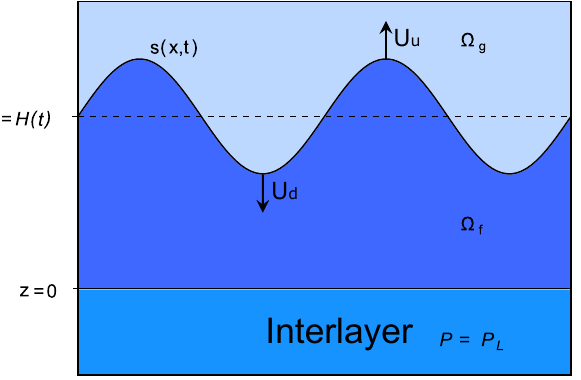
Figure 1. The computational domain used for the Darcy scale numerical simulation. Ω f is the low-permeability liquid region, Ω g the gas region. The highly permeable layer (the interlayer) is located at z <